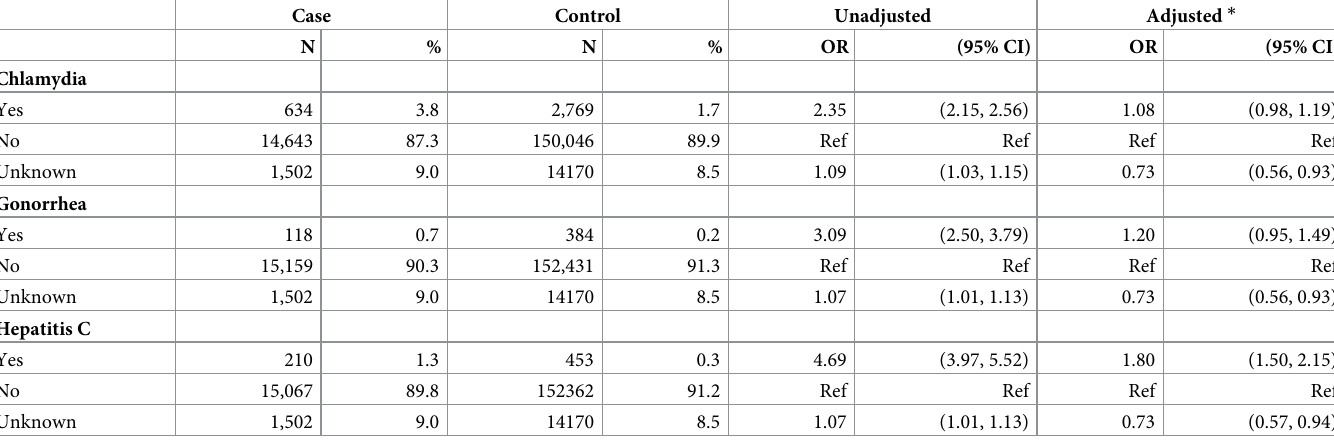
Table 3. Number, percentage and unadjusted and adjusted odds ratios (OR) and their 95% confidence intervals (CI) for chlamydia, gonorrhea and hepatitis C. Case